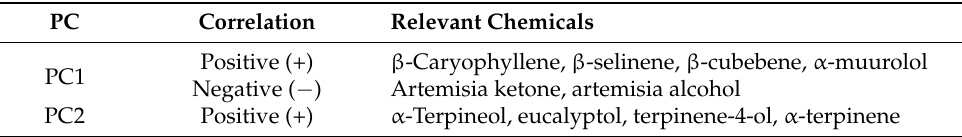
Table 5. Correlation of common chemicals from A. annua essential oils with each principal component (PC1 and